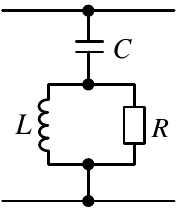
Figure 9. Second-order high-pass filter.